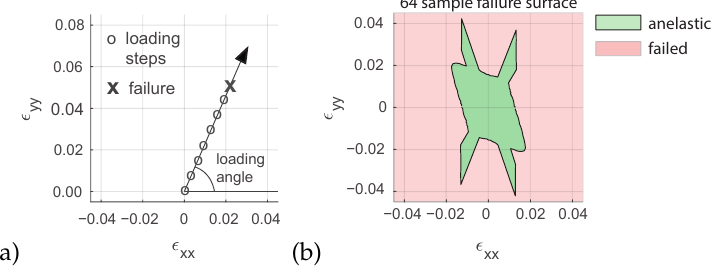
Figure 4. Strain space macroscopic incremental loading ( a ). Failure surface in the xx – yy strain space separating the anelastic non-failed region and failed region, 64 samples resolution ( b